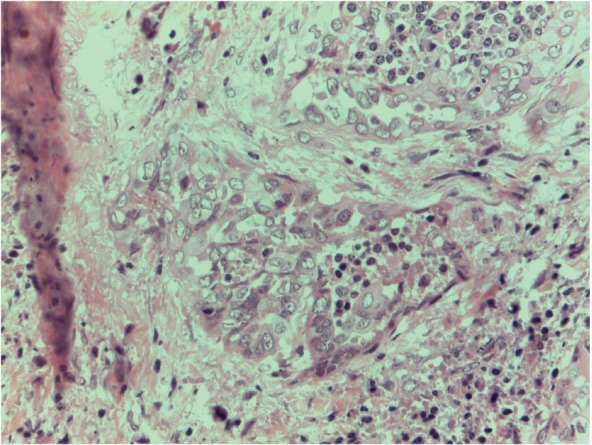
Papillary carcinoma sclerosing variant x400 magnification.